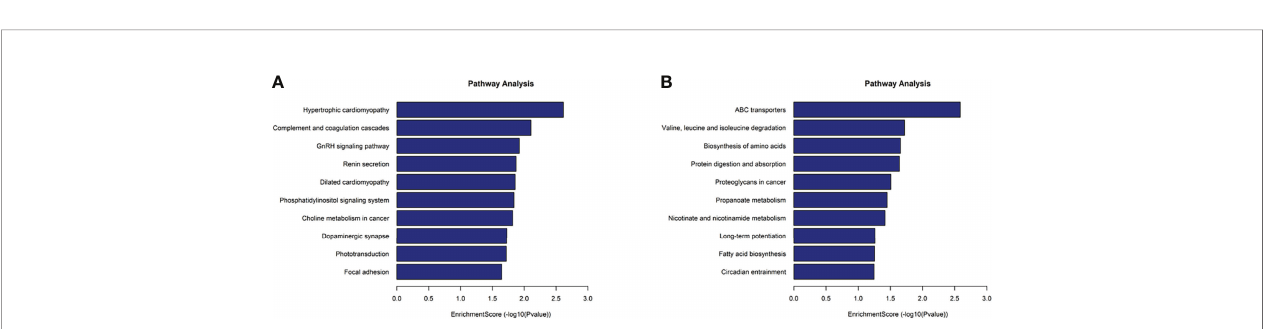
FIGURE 4 | GO analysis on different m7G methylation genes of HL60 and HL60/MX2 cells. (A-C) GO enrichment analysis of up-methylated m7G genes in HL60/ MX2 cells. (D-F) GO enrichment analysis of down-methylated m7G genes in HL60/MX2 cells. GO, gene ontology; BP, biological process; CC, cellular component; MF, molecular